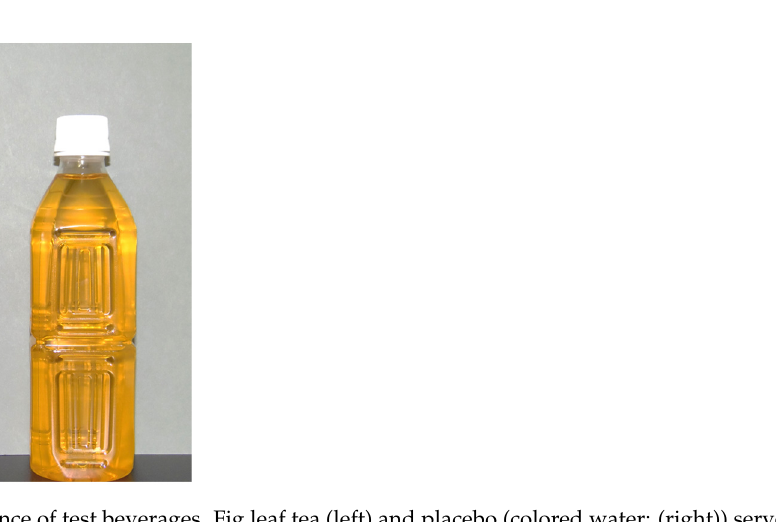
Figure 2. Appearance of test beverages. Fig leaf tea ( left ) and placebo (colored water: ( right )) served in 500 mL PET bottles.